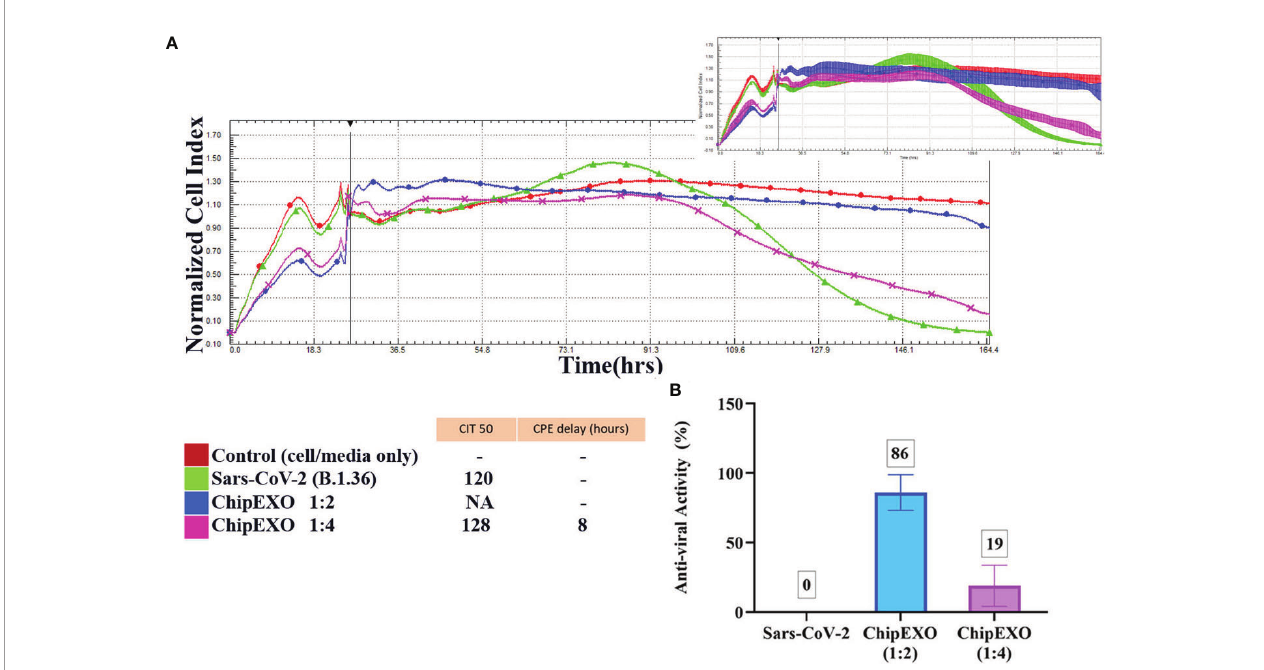
FIGURE 7 | The antiviral ef fi cacy of ChipEXO was evaluated using the xCELLigence RTCA MP real-time cell analysis equipment.The xCELLigence system ’ s cell index (CI) for Vero E6 cells in media (red line), or after viral inoculation (3.5 × 105 PFU/ml), or alone (green line) (A) . CI in the presence of virus and ChipEXO from two different concentrations, respectively (1/2 and 1/4) (B) . In the top right corner, a smaller second graph displays the same data with the standard deviation added. The bar graph and table depicted the antiviral activity rate of ChipEXO and the CITmed and CPE delay hours, respectively. Each curve was obtained from at least three separate duplicates of normalized cell index (NCI)